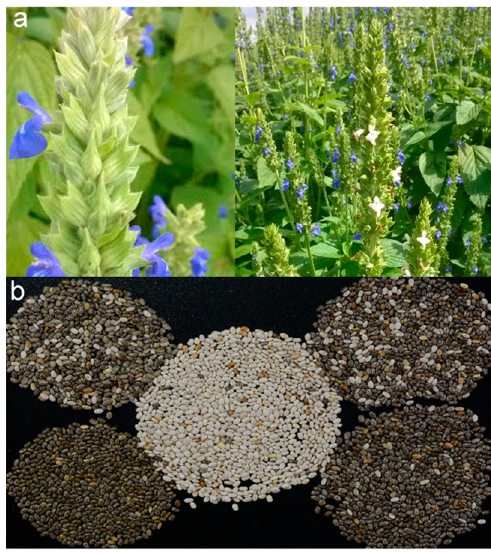
Figure 1. Chia plants, flowers and seeds. ( a ) Purple and white flowers, ( b ) Seeds from different commercial lines cultivated in